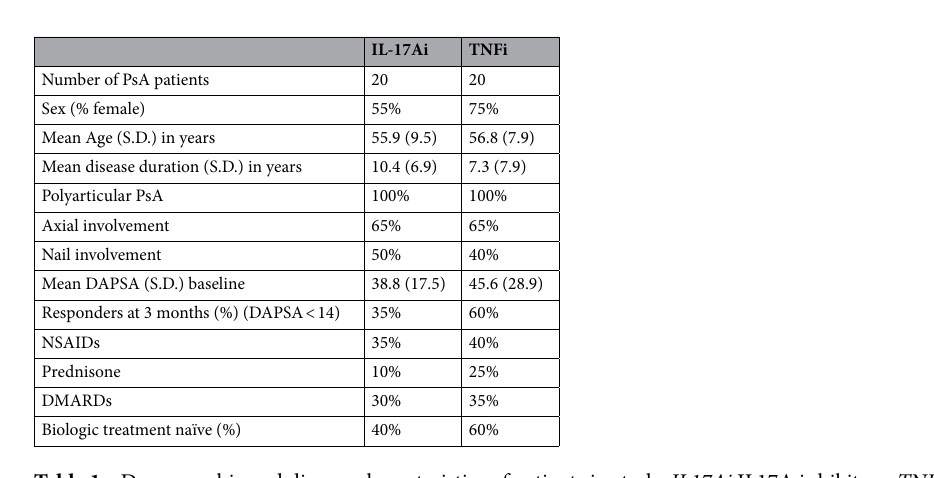
Table 1. Demographic and disease characteristics of patients in study. IL17Ai IL17A inhibitors; TNFi TNF inhibitors; DAPSA Disease Activity Index for Psoriatic Arthritis.